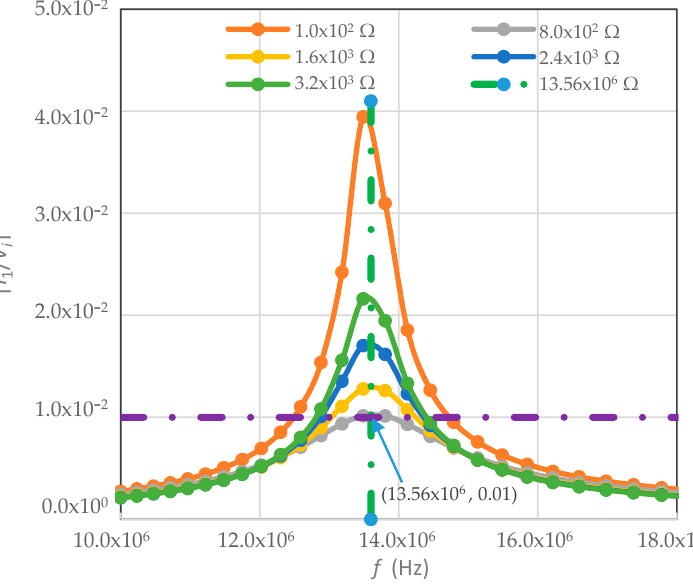
Figure 14. Response of | I 1 / V i | at various loads.